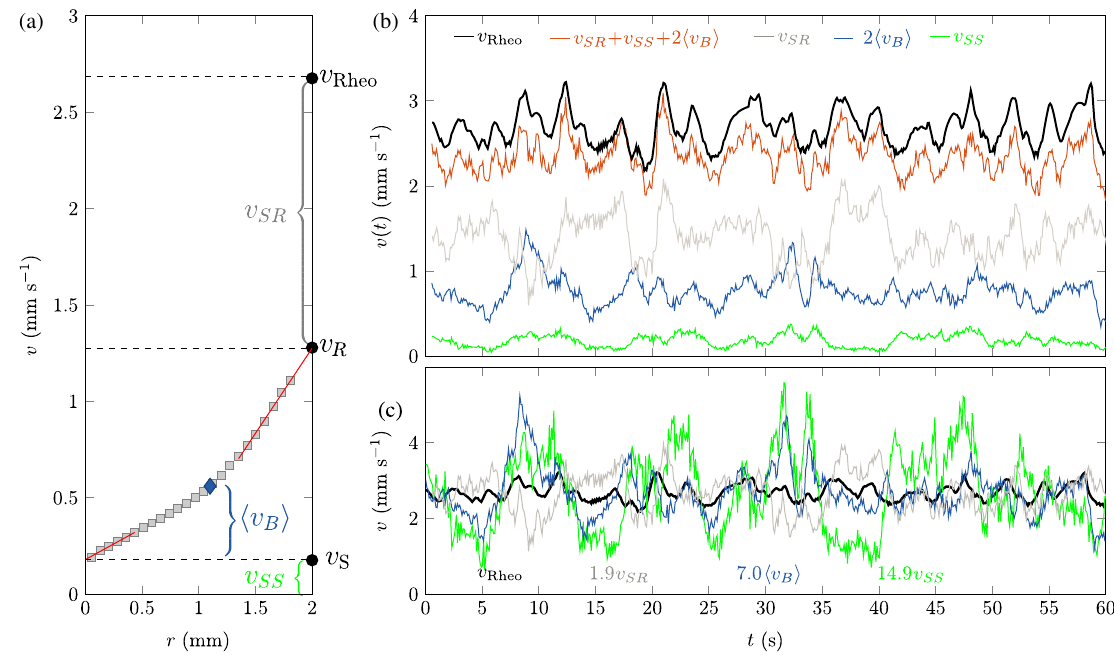
FIG. 16. Same as Fig. 14 in regime II for σ ¼ 80